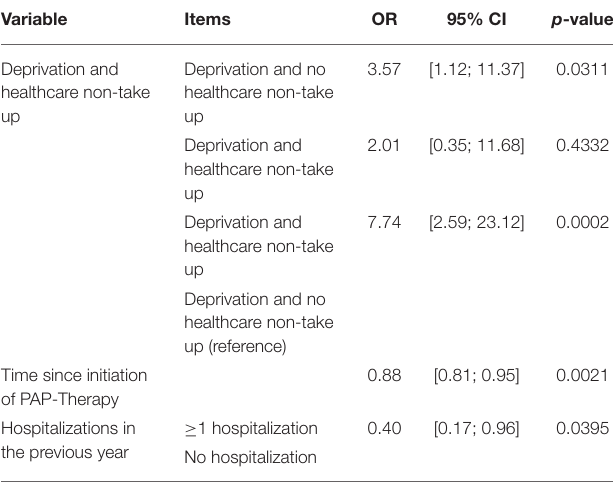
TABLE 3 | Multivariable association between predictors and the probability of being non-compliant ( N = 266).